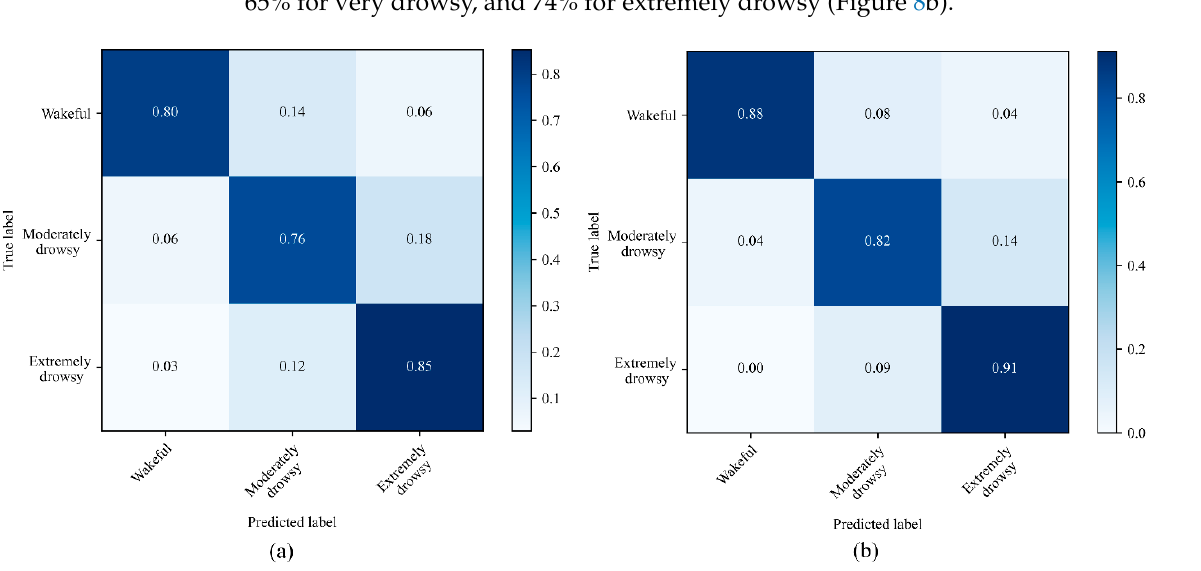
Figure 7. Normalized confusion matrices for the 3-level drowsiness classification in the ( a ) CNN model and the ( b ) CNN-LSTM model. For this classification, we considered ORD < 3 as wakeful, ORD = 3 as moderately drowsy, and ORD > 3 as extremely drowsy. ORD: observer rating of drowsiness.